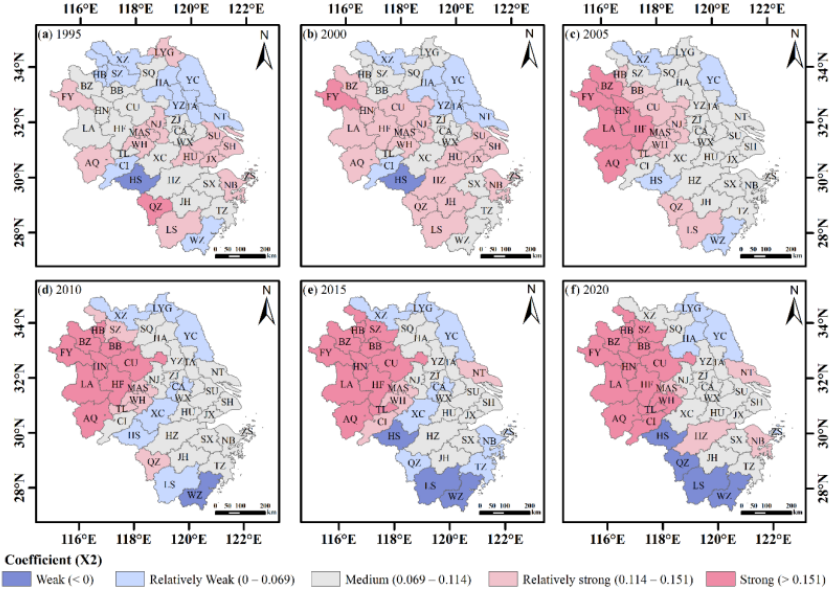
Figure A2. Spatial distribution of the regression coefficients of the land use structure.